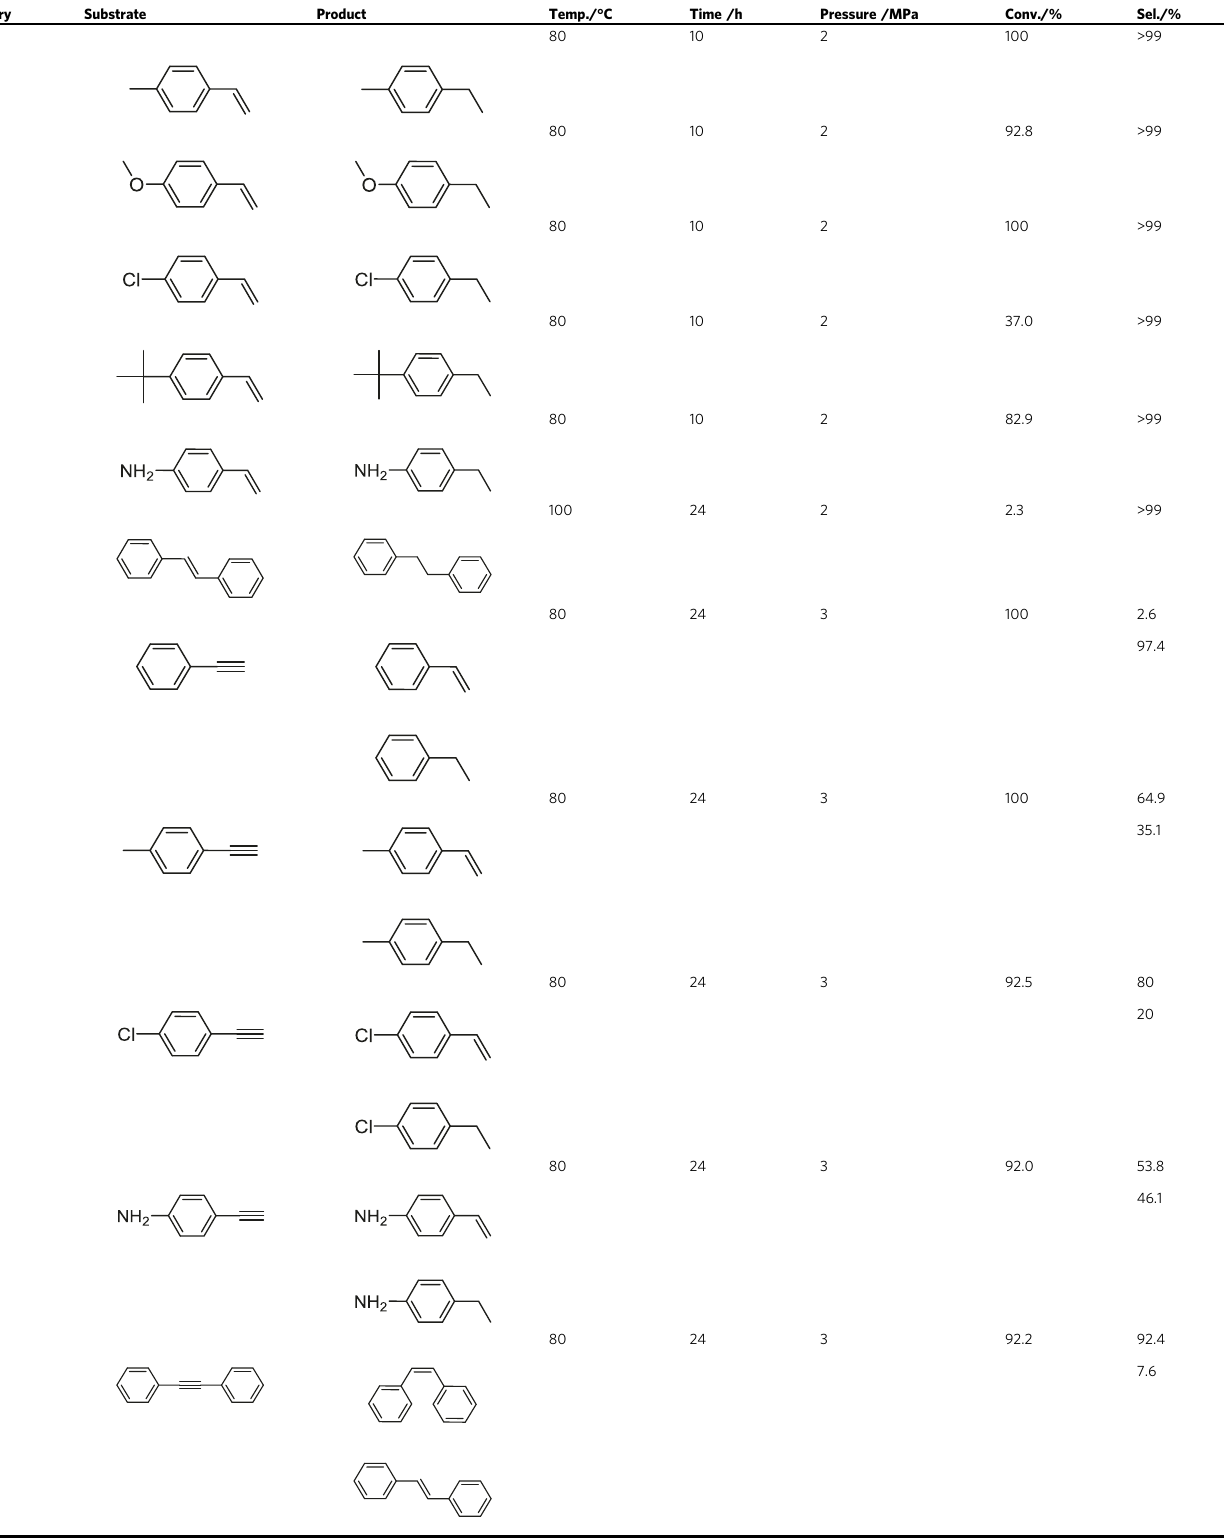
Table 2 Scope of AlOOH-U2 for catalytic hydrogenation of alkenes and alkynes a . Entry